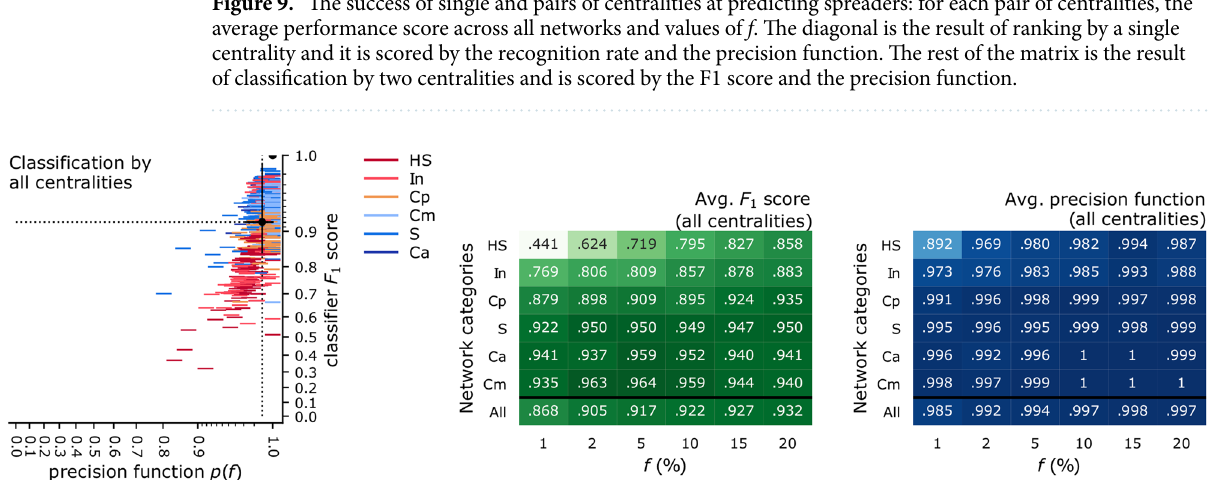
Figure 10. The success of classifiers using all centralities at predicting spreaders, across all networks and values of f , at the SIR epidemic threshold. (left) Each data point denotes a prediction task, and the colour shows the category of the network (listed in Table 1). The centroid of the point cluster and the standard deviation on both axes are marked (counterpart to Fig. 5). (right) The average performance scores across all networks in one of six network categories, and across all values of f (counterpart to Fig.